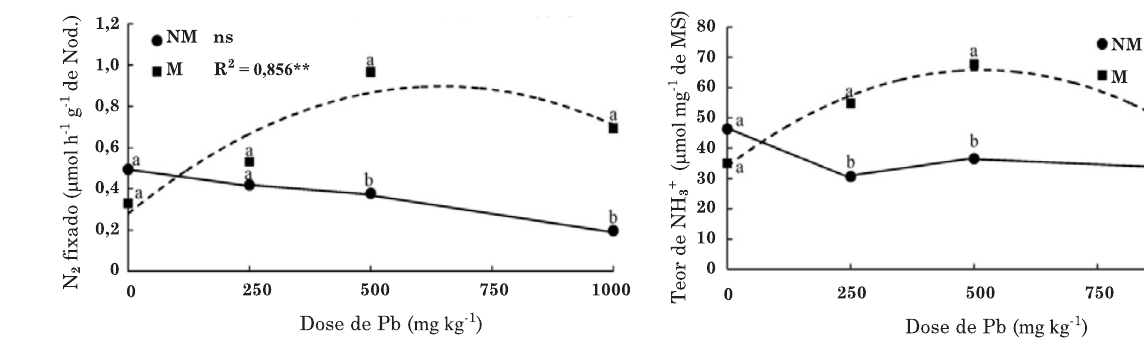
Figura 7. Teor de amônia em folhas de plantas de Stizolobium aterrimum não micorrizadas (NM – linha contínua) e micorrizadas (M – linha tracejada) crescendo em solo com doses crescentes de Pb. Letras iguais não diferem entre si pelo teste de Tukey a 5 % entre os tratamentos NM e M, dentro de cada dose de